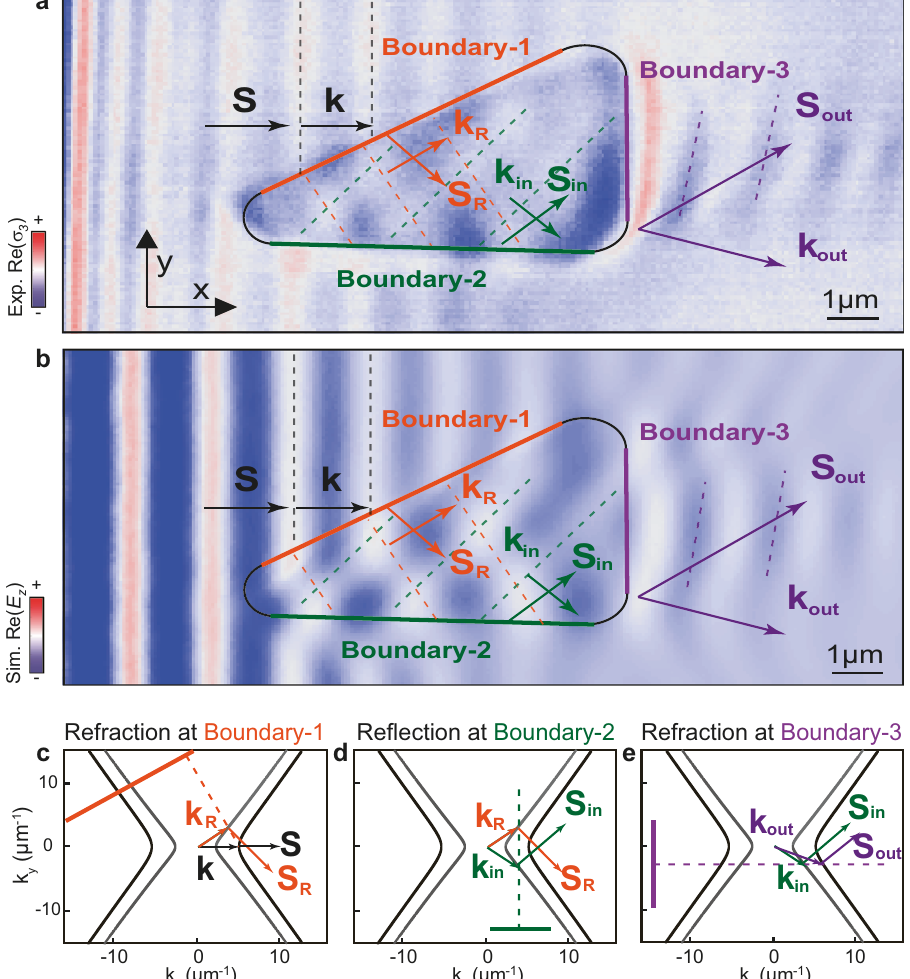
Fig. 4 Real-space visualization of the general case of refraction between two anisotropic media using nanoscale-con fi ned HPhPs passing through a (cid:3) (cid:4) near- fi eld images of polaritons propagating in a 231-nm-thick α -MoO 3 fl ake at λ 0 = 11.0 μ m. The bending-free planar prism. a Experimental Re σ 3 x ; y ð Þ black contour line marks a triangular prism fabricated by etching an air cavity on the SiO 2 substrate below the α -MoO 3 fl ake. A fi rst refraction takes place at boundary-1 (orange solid line) for incident polaritons with collinear k and S (black arrows), yielding refracted polaritons with non-collinear k R and S R (orange arrows). These polaritons then re fl ect at boundary-2 (green solid line), yielding polaritons with non-collinear k and S (green arrows). A second in in refraction at boundary-3 (violet solid line) yields polaritons with non-collinear k out and S out (violet arrows). b Simulated Re ð E z ð x ; y ÞÞ near- fi eld images of HPhPs for the case shown in a . Dashed lines in experimental and simulated near- fi eld images indicate the wavefronts of polaritons as they pass through the prisms. c – e Analytic IFCs of HPhPs in MoO 3 /air (gray curve) and MoO 3 /SiO 2 (black curve), predicting the directions of refraction or re fl ection of HPhPs at boundary-1 ( c ), boundary-2 ( d ), and boundary-3 ( e ) based on momentum conservation. The orange ( c ), green ( d ), and purple ( e ) solid lines represent the boundary-1, boundary-2, and boundary-3, while the corresponding dashed lines represent the normal to the